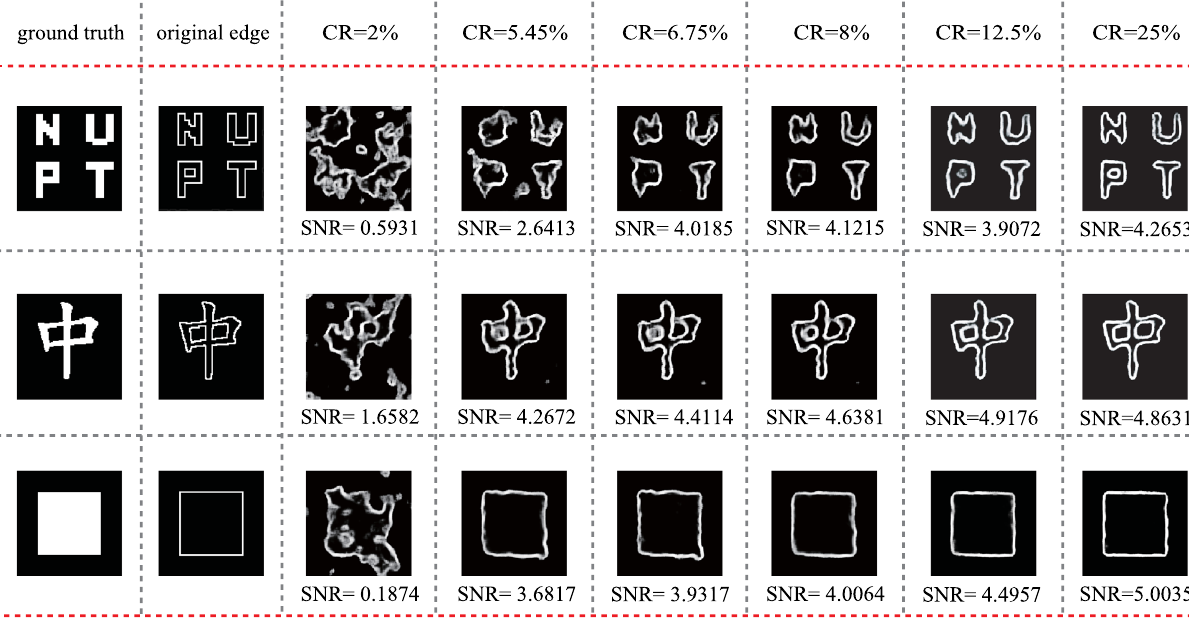
Fig. 5 Experimental results obtained by using proposed ghost edge detection scheme with different